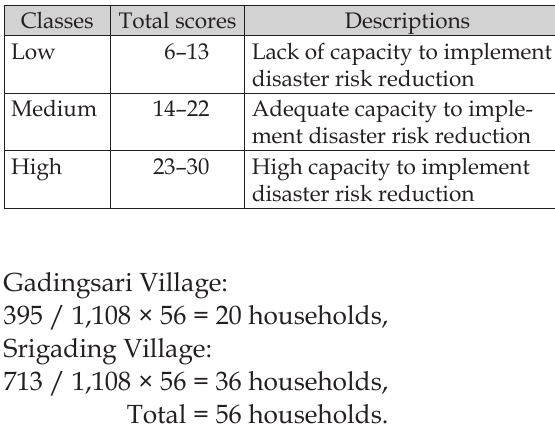
Table 2. The classification of capacity levels.